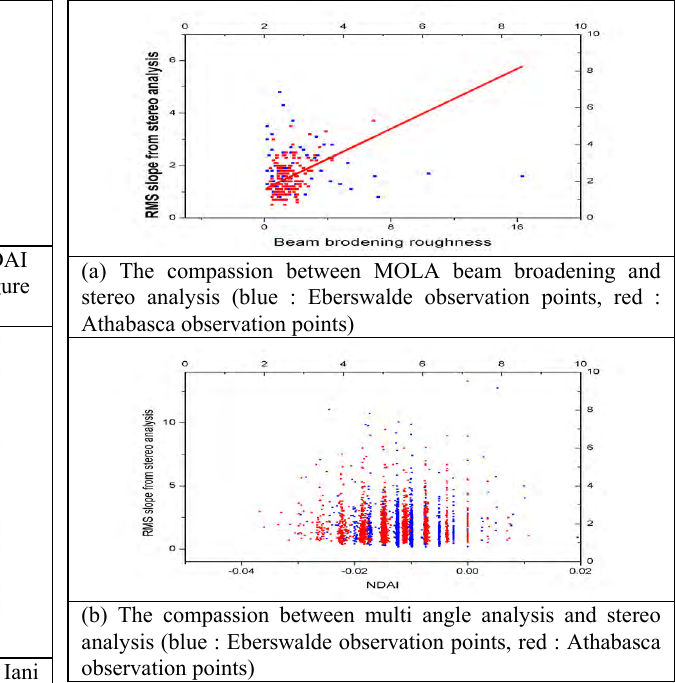
Figure 5. The correlation between the local roughness parameter by stereo analysis and the other